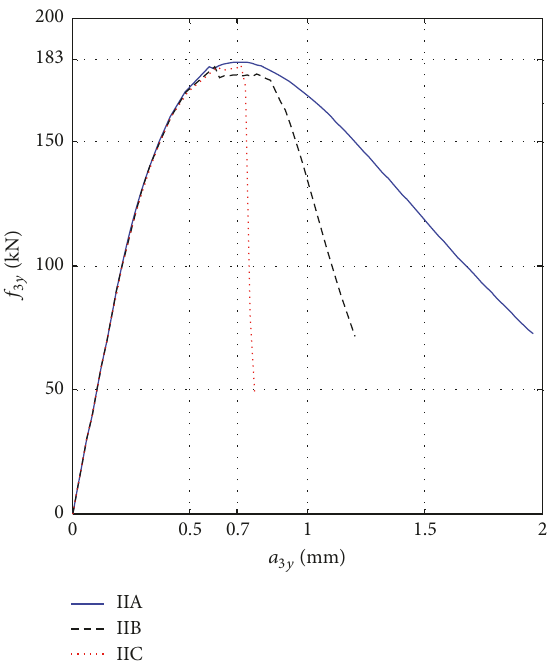
Figure 4: Load-deflection curve of node 3 in 𝑦 direction of Model